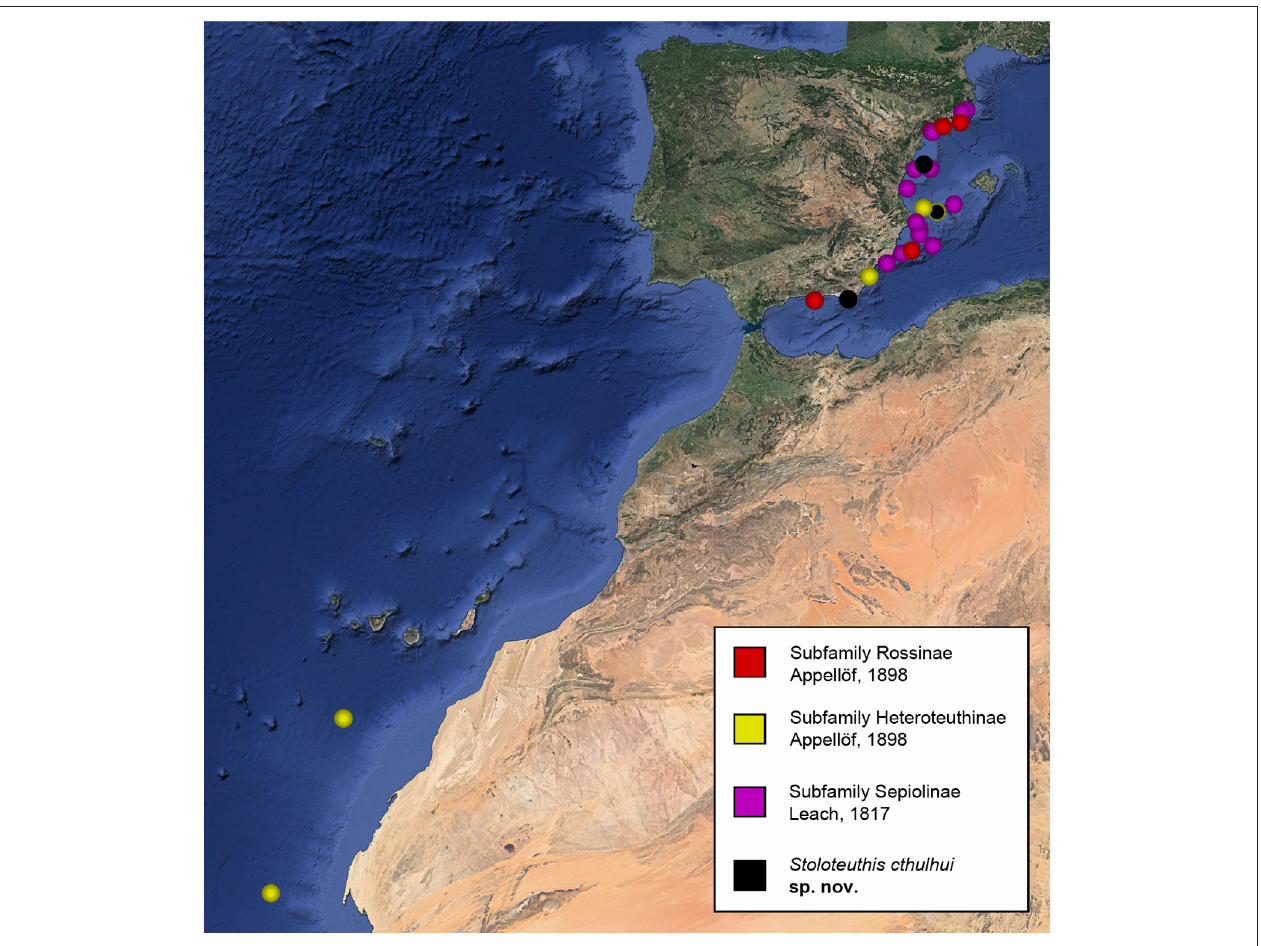
FIGURE 1 | Sampling localities of the specimens sequenced in this work sorted by subfamilies. Sampling localities of Stoloteuthis cthulhui sp. nov . are also indicated. Modified from Google Earth